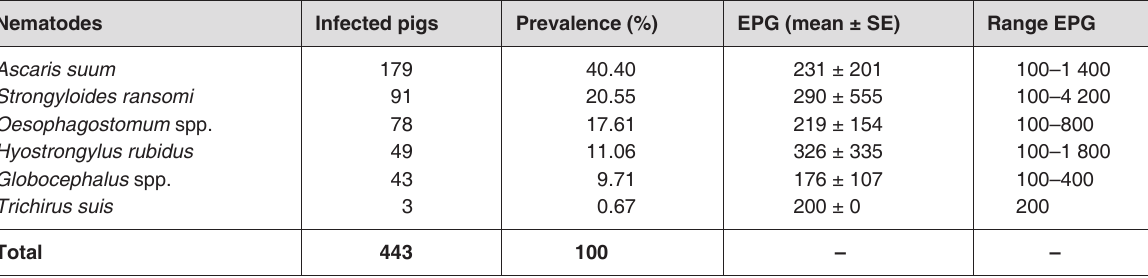
The prevalence rate was calculated on the basis of the number of